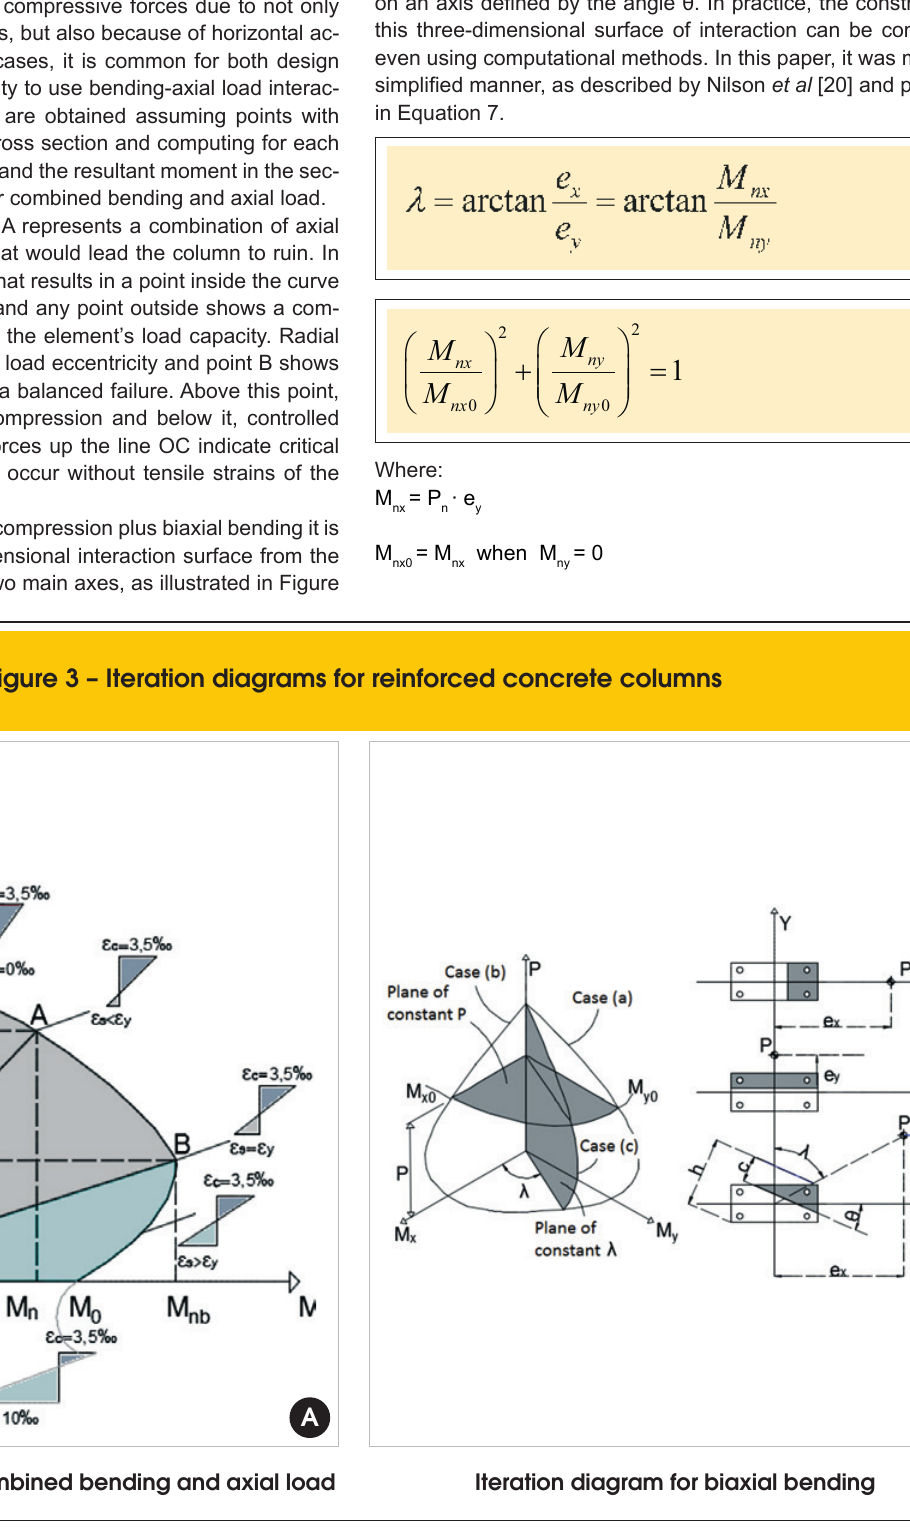
Iteration diagram for combined bending and axial load Iteration diagram for biaxial